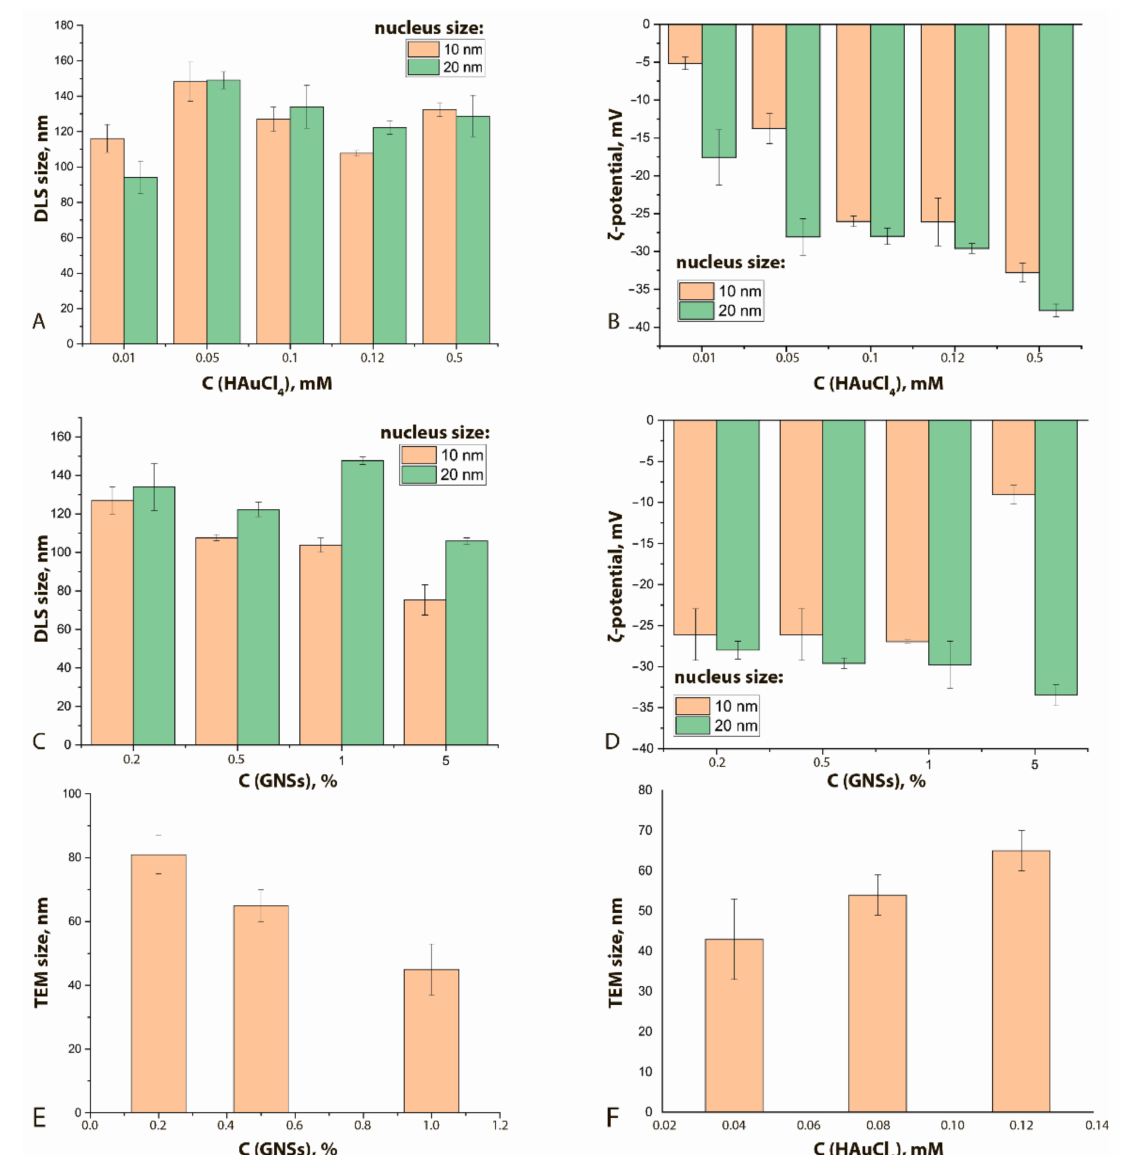
Figure 4. Influence of HAuCl 4 concentration on the hydrodynamic diameter ( A ) and on ζ -potential ( B ) of GNFs (C(nucleus) = 0.2%). Influence of the concentration of nuclei (%) on the hydrodynamic diameters of GNFs ( C ) and on the ζ -potential ( D ) (C(HAuCl 4 ) = 0.12 mM). Influence of the concentrations of nuclei (%, ( E )) and HAuCl 4 (mM, ( F )) on the TEM-registered average diameters of GNFs (nucleus size 20